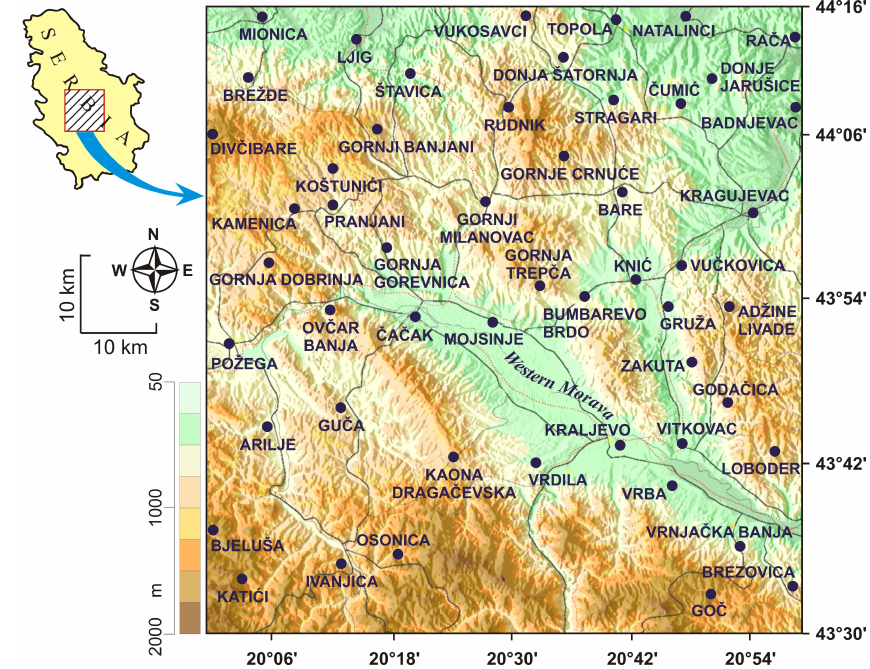
Fig. 1. Study area with rain gauge